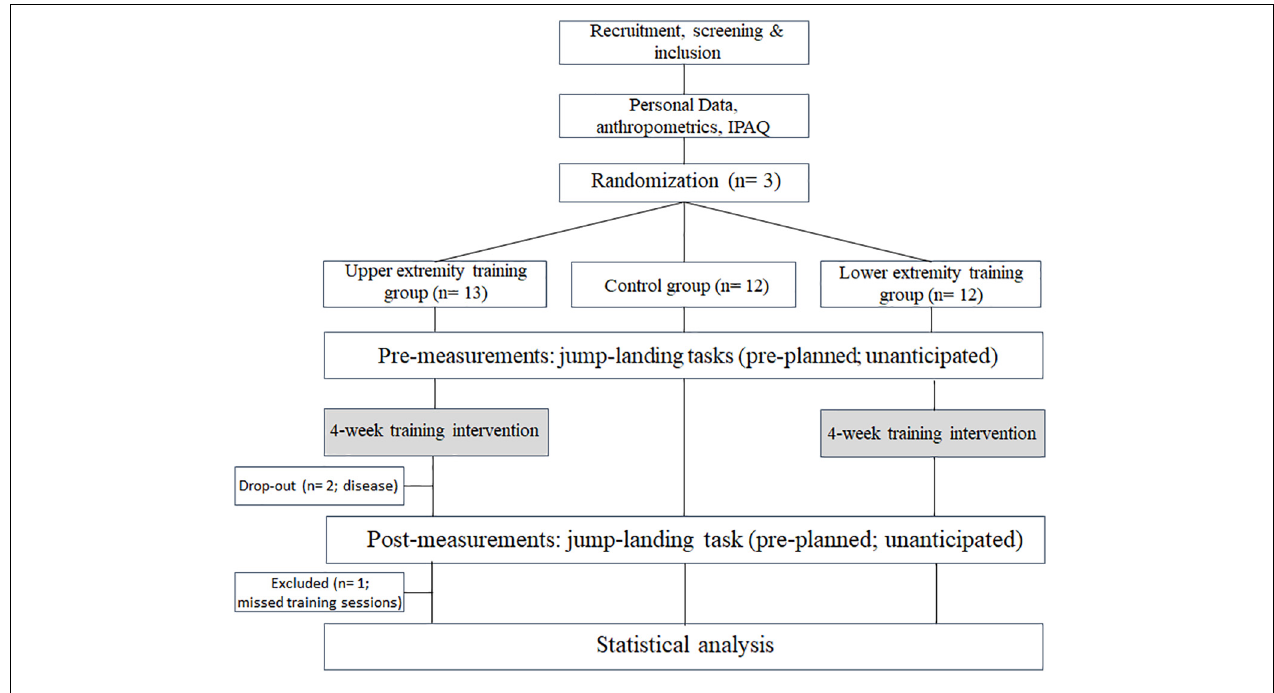
FIGURE 2 | Study and participants flow. TABLE 1 | Anthropometrics and health related data of the study collective (separated by groups and total sample). Outcome (mean, SD) Total sample Control group Intervention